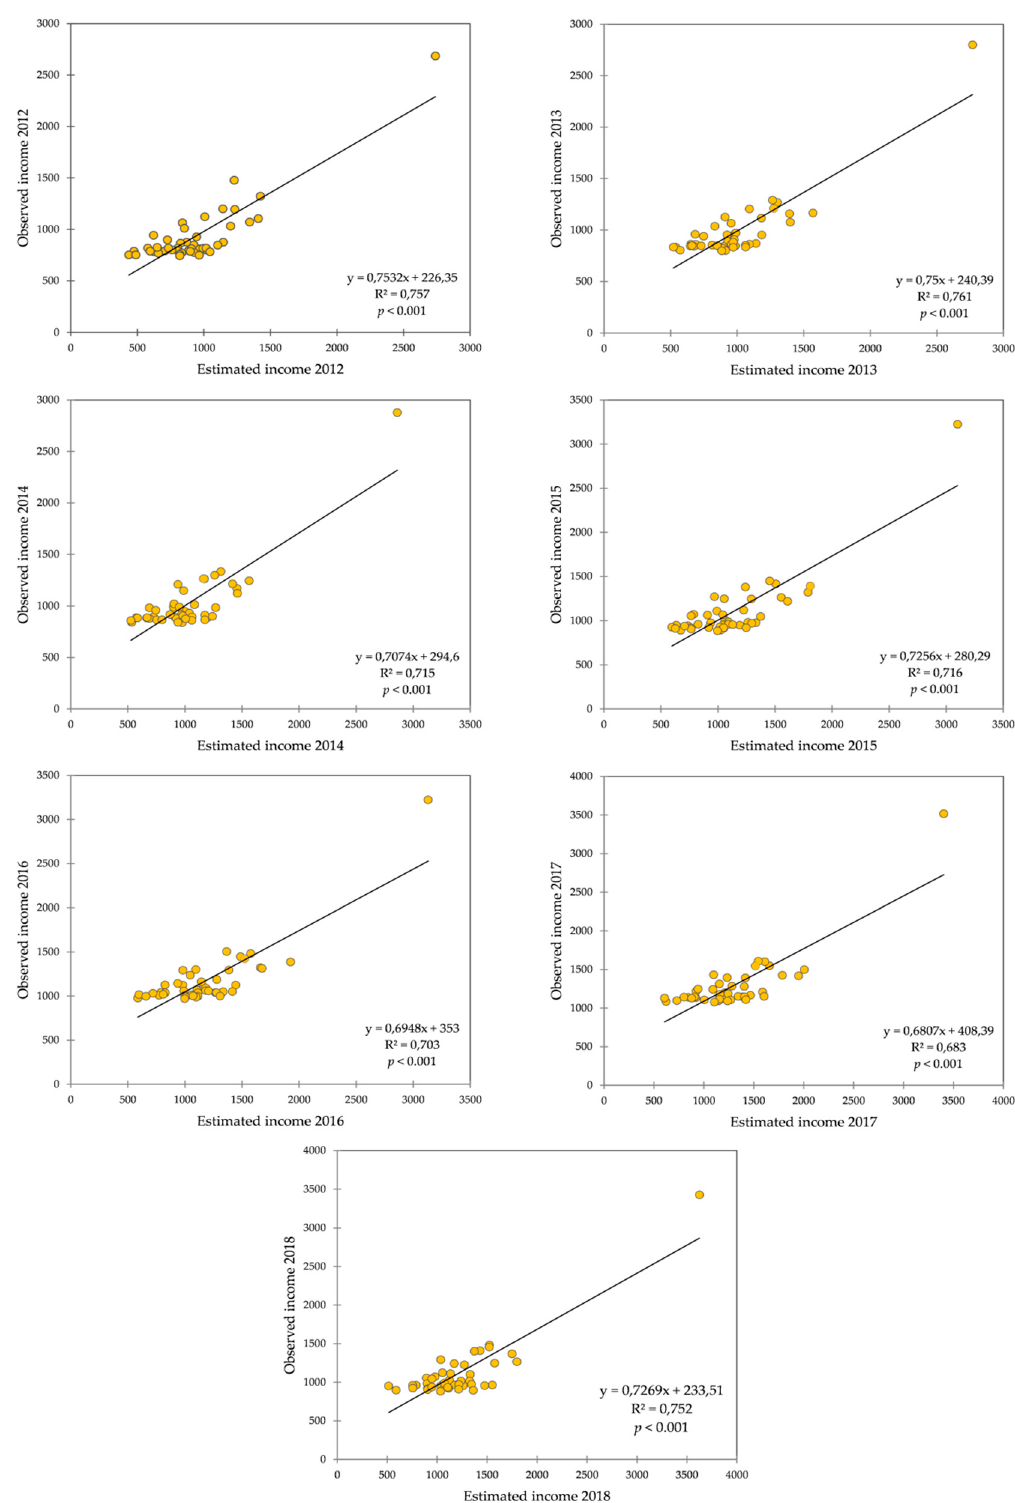
Figure 4. Linear regression model between observed and estimated income (RON/person).